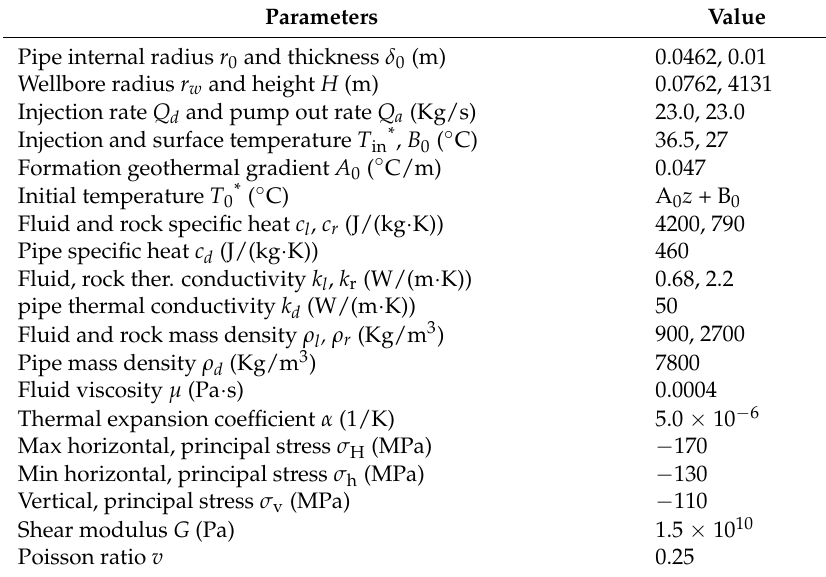
Table 1. Parameters for the